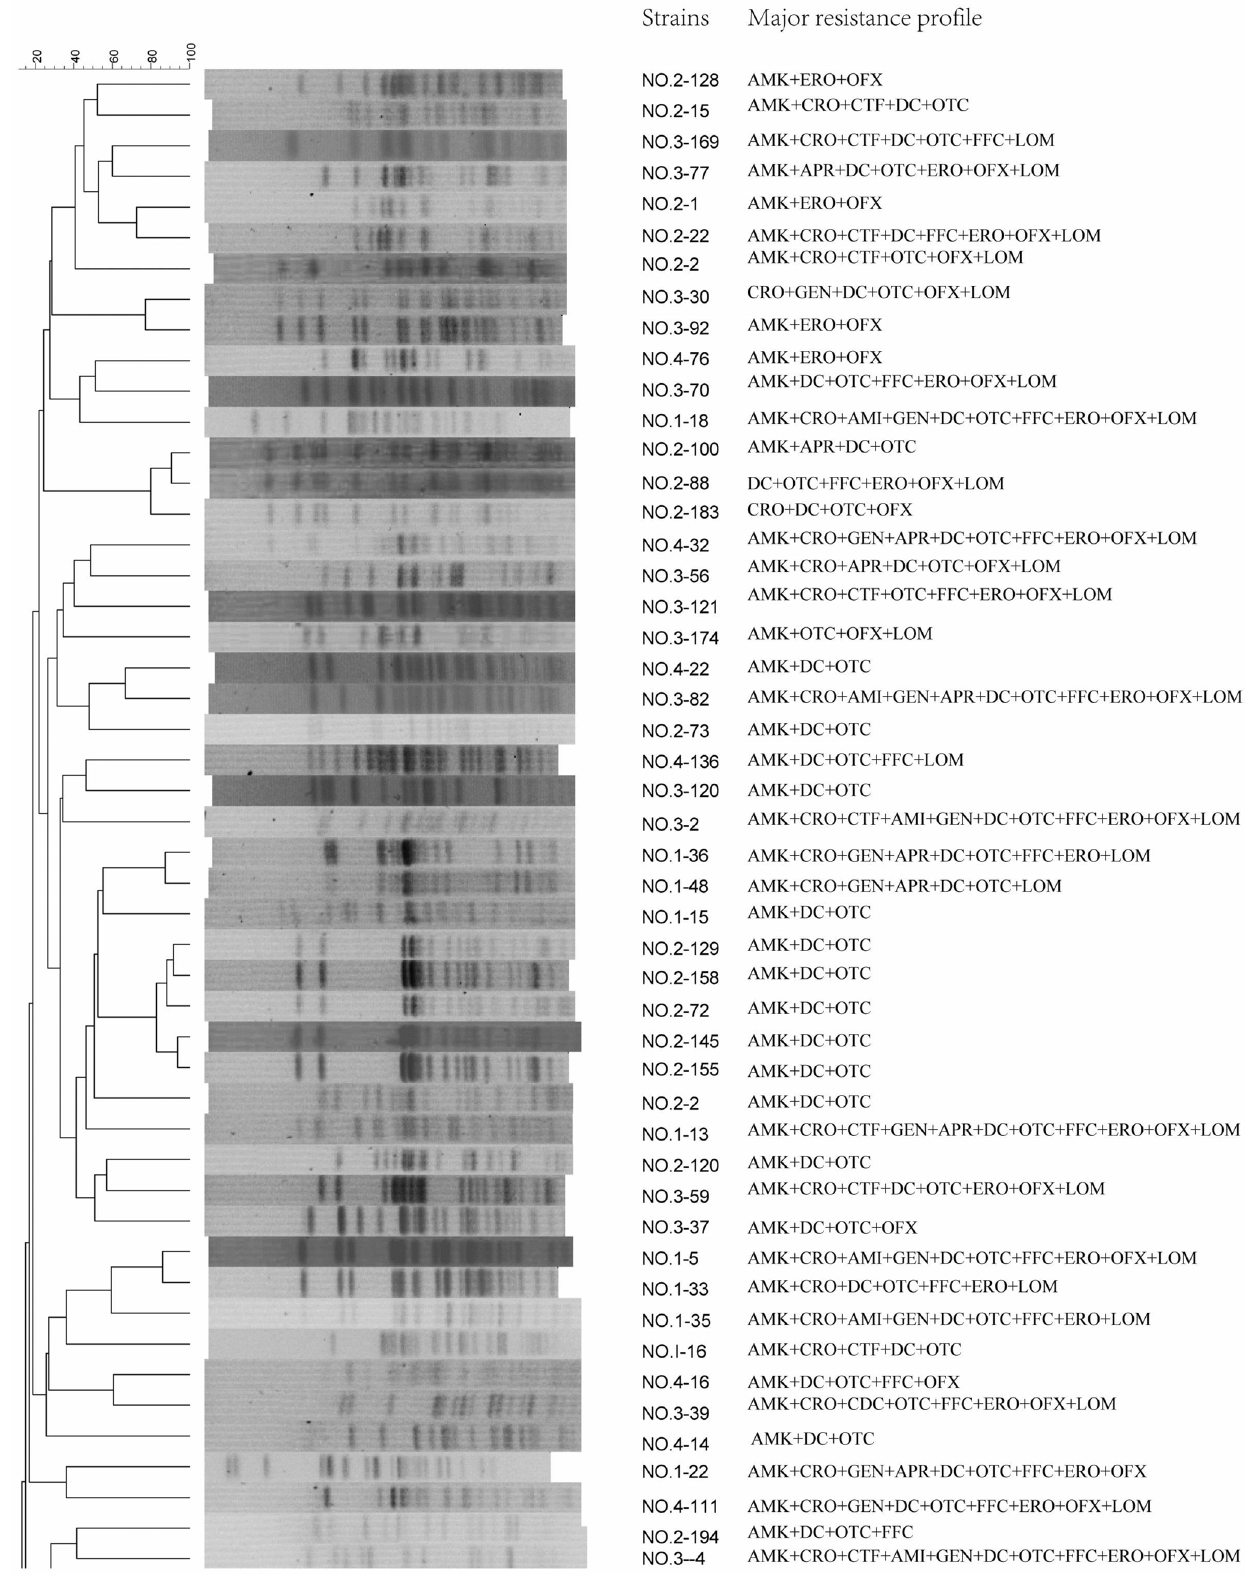
Figure 3. Comparison of the Xba I-PFGE patterns of 49 Escherichiacoli isolates from chicken feces from chicken farms in the Anhui Province of China.